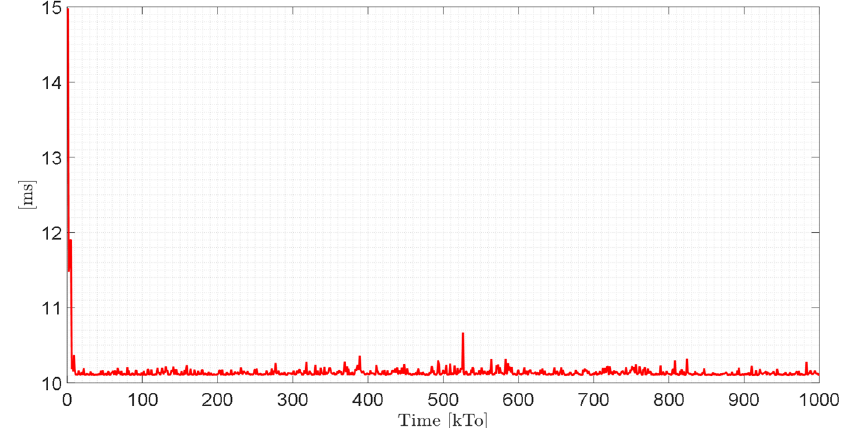
Figure 28. Execution time of the proposed closed-loop control scheme.